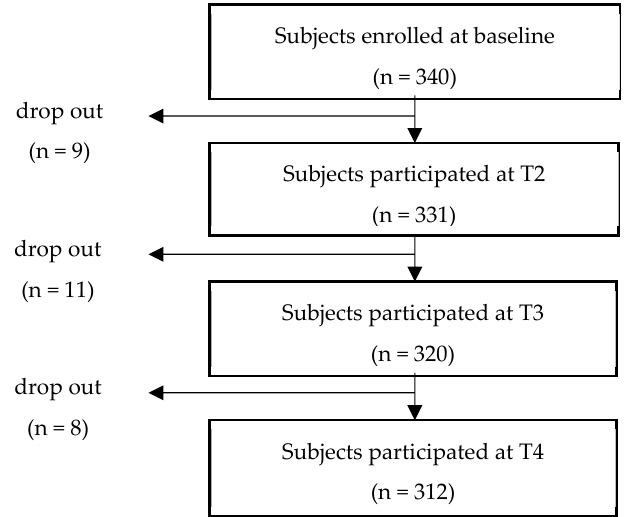
Figure 1. The flow of drop-outs each year.